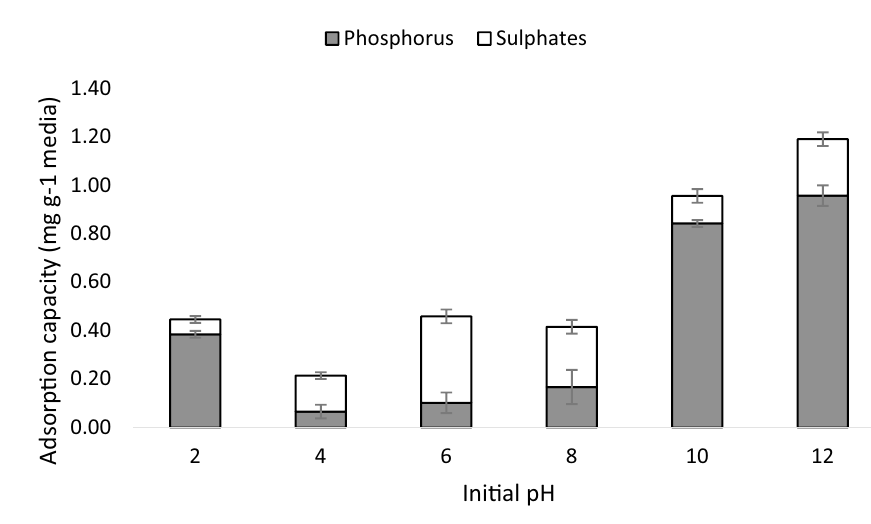
Fig. 8 Effect of pH on the adsorption of phosphorus and Sulphates onto copper smelter